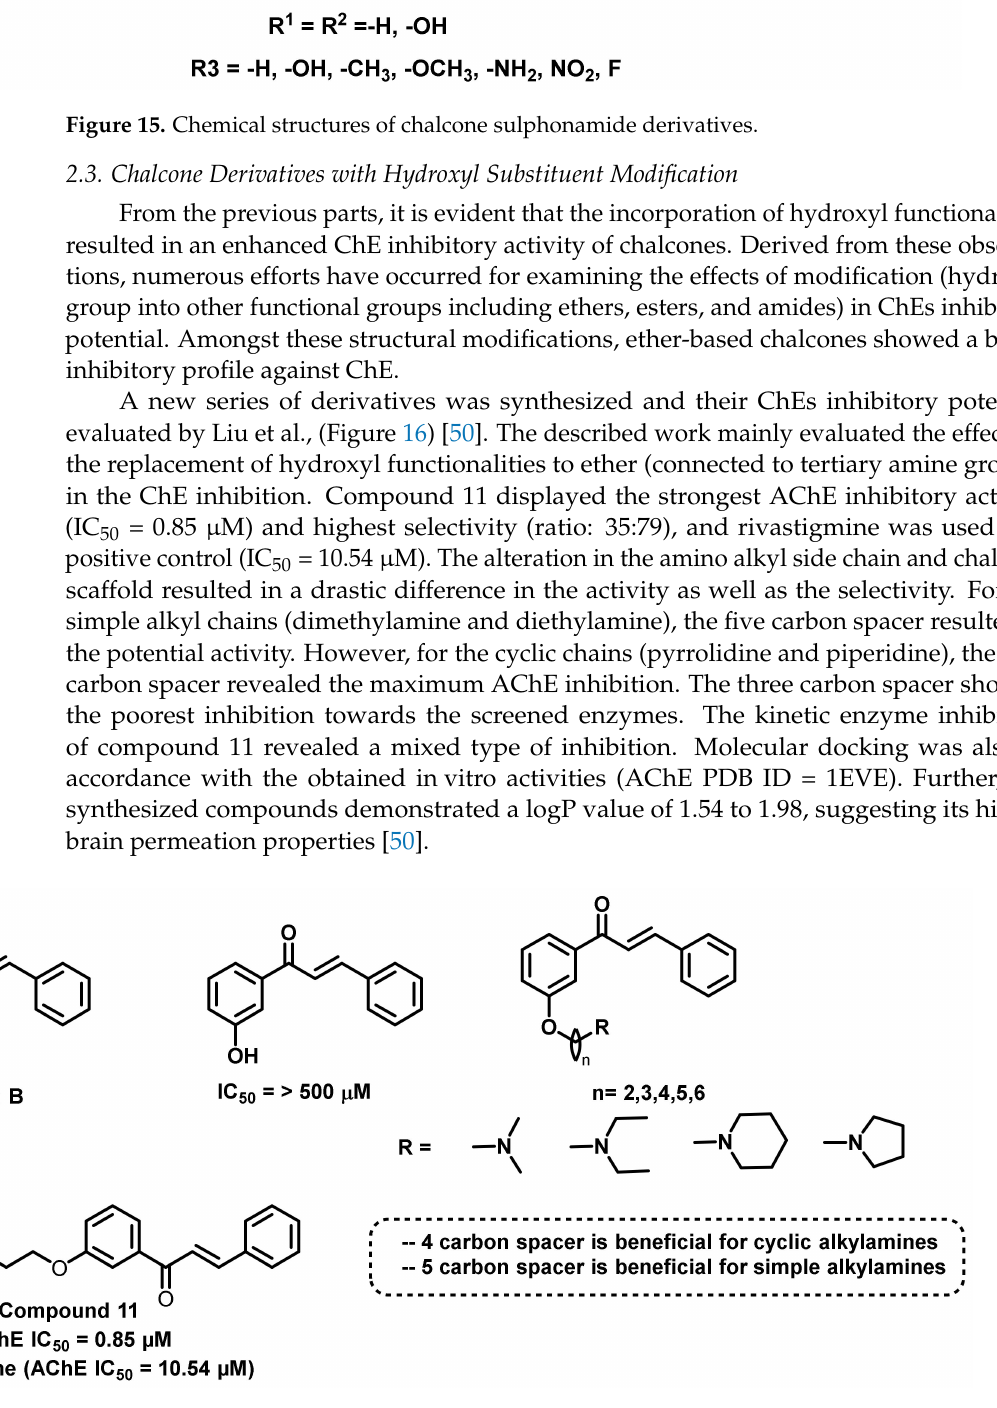
Figure 16. Ether-substituted chalcone derivatives reported by Liu et